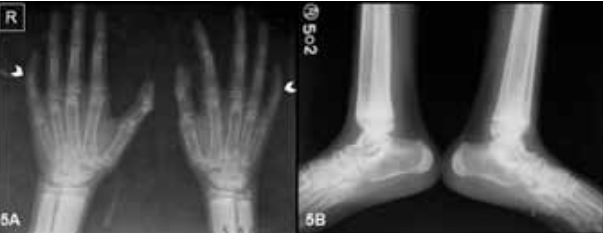
Fig. 5. X-rays of both hands with AP view (5A) and ankles with lower leg lateral view (5B) reveal broad tubular bones and marked hypoplasia of the middle phalanges in the fifth fingers (white arrowheads) with